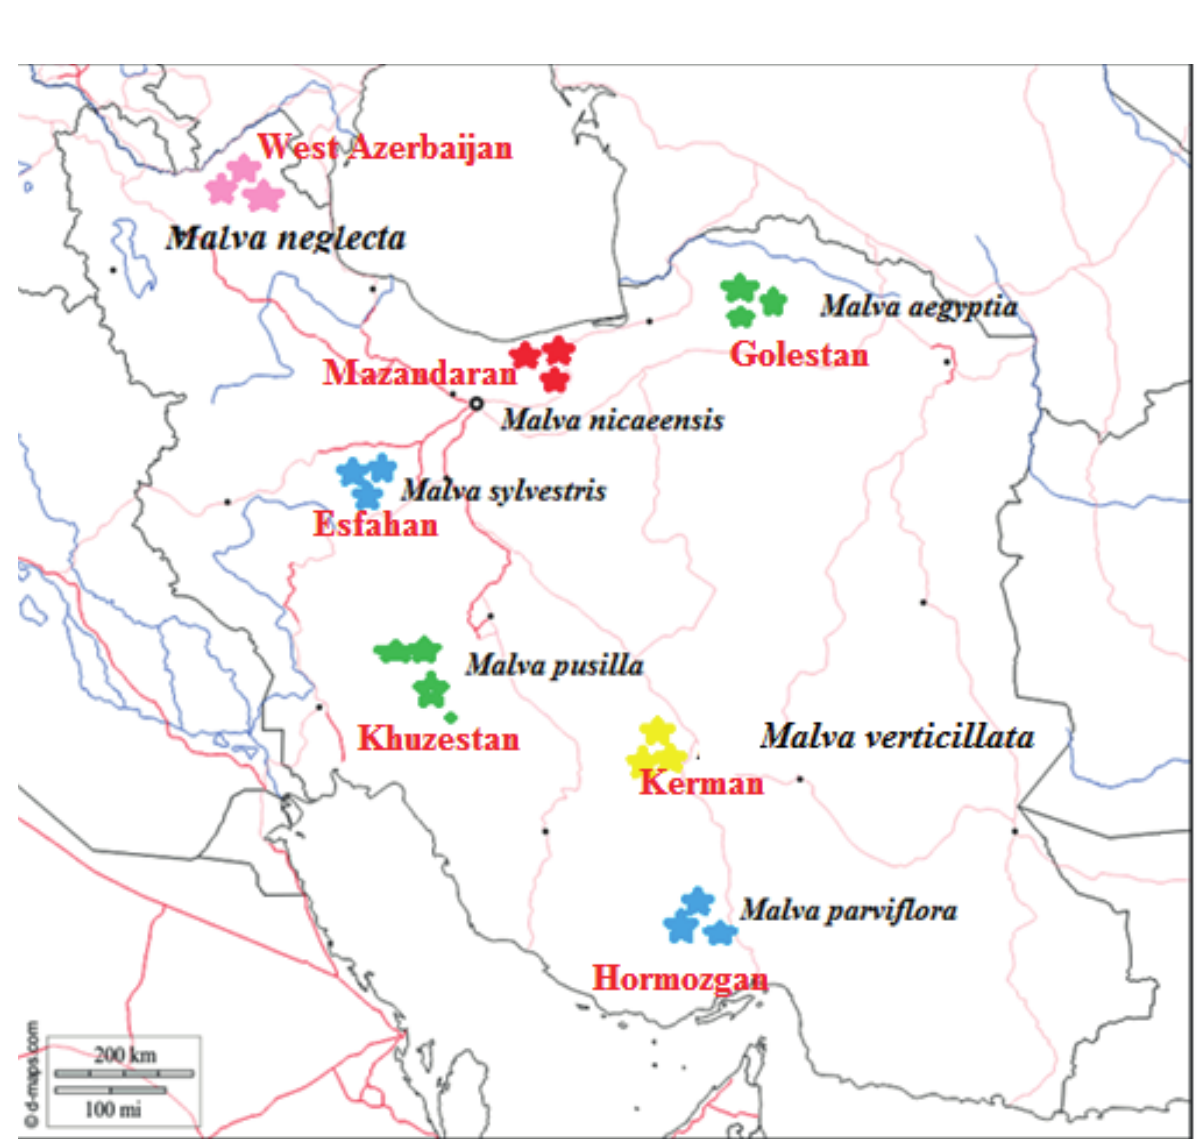
Figure 1. Presence of species in different regions of